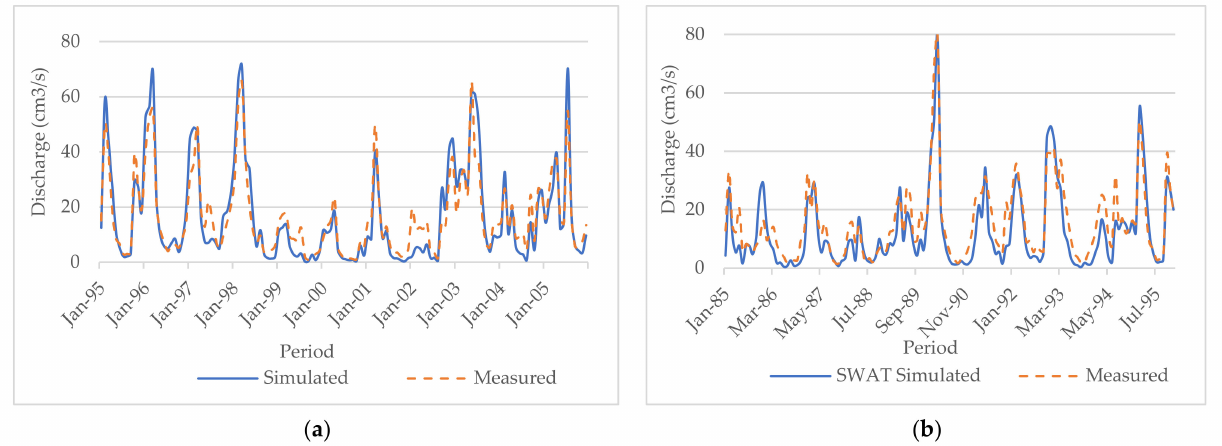
Figure 6. Monthly streamflow hydrographs for ( a ) calibration and ( b ) validation periods at USGS gage 02413300, on the Little Tallapoosa River near Newell.